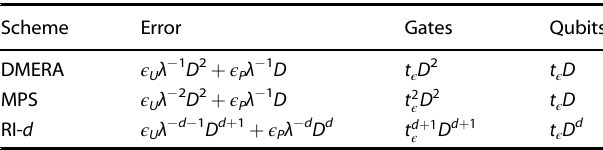
Table 1. Summary of